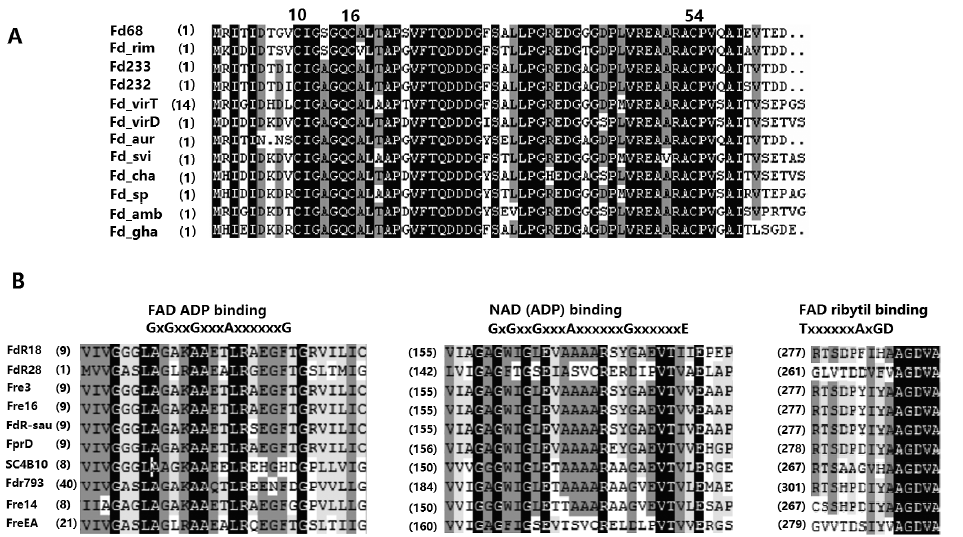
Figure 2. Sequence alignments of ferredoxins and ferredoxin reductases. (A) Alignment of the amino acid sequence of Fd68 from S. ahygroscopicus ZB01 with different 3Fe-4S-Fds. Fd_rim( ZP_20965346 ) is from S. tubercidicus ;Fd233( AY549200 ) is from S. tubercidicus R-922; Fd232( AY552101 ) is from S. tubercidicus I-1529; Fd_virT( WP_003995703 ) is from S. Viridochromogenes ; Fd_virD( ZP_07308348 ) is from S. viridochromogenes DSM 40736; Fd_aur( ZP_10545293 ) is from S. auratus AGR0001; Fd_svi( ZP_06921672 ) is from S. sviceus ATCC 29083; Fd_cha( ZP_06921672 ) is from S. sviceus ATCC 29083; Fd_sp( BAG55293 ) is from Streptomyces sp. A-1544; Fd_amb( CAJ88533 ) is from S. ambofaciens ATCC 23877; Fd_gha( ZP_06574442 ) is from S. ghanaensis ATCC 14672. (B) Multiple sequence alignment of conserved regions in FdRs. Consensus sequences for the FAD ADP-binding motifs, the NAD (ADP)-binding motifs, and the FAD ribytil-binding motifs (Asturis 1995) are shown above the alignment. FdR18, FdR28 are the FdRs described in this study. FprD( NP_826852.1) is from S. avermitilis MA-4680. Fre3( AAT45306.1) , Fre14( AAT45308.1) , Fre16( AAT45309.1) , FreEA( AAT45279.1 ) are from the genome of S. tubercidicus (Molnar, 2005). Fdr793( AJ628764.1) is of S. peucetius ATCC27952. SCF15( CAB60462.1 ) and SC4B10( CAC04223.1 ) are of S. coelicolor A3(2); FdR-sau(sau, EJJ04871.1 ) is of S. auratus AGR0001.